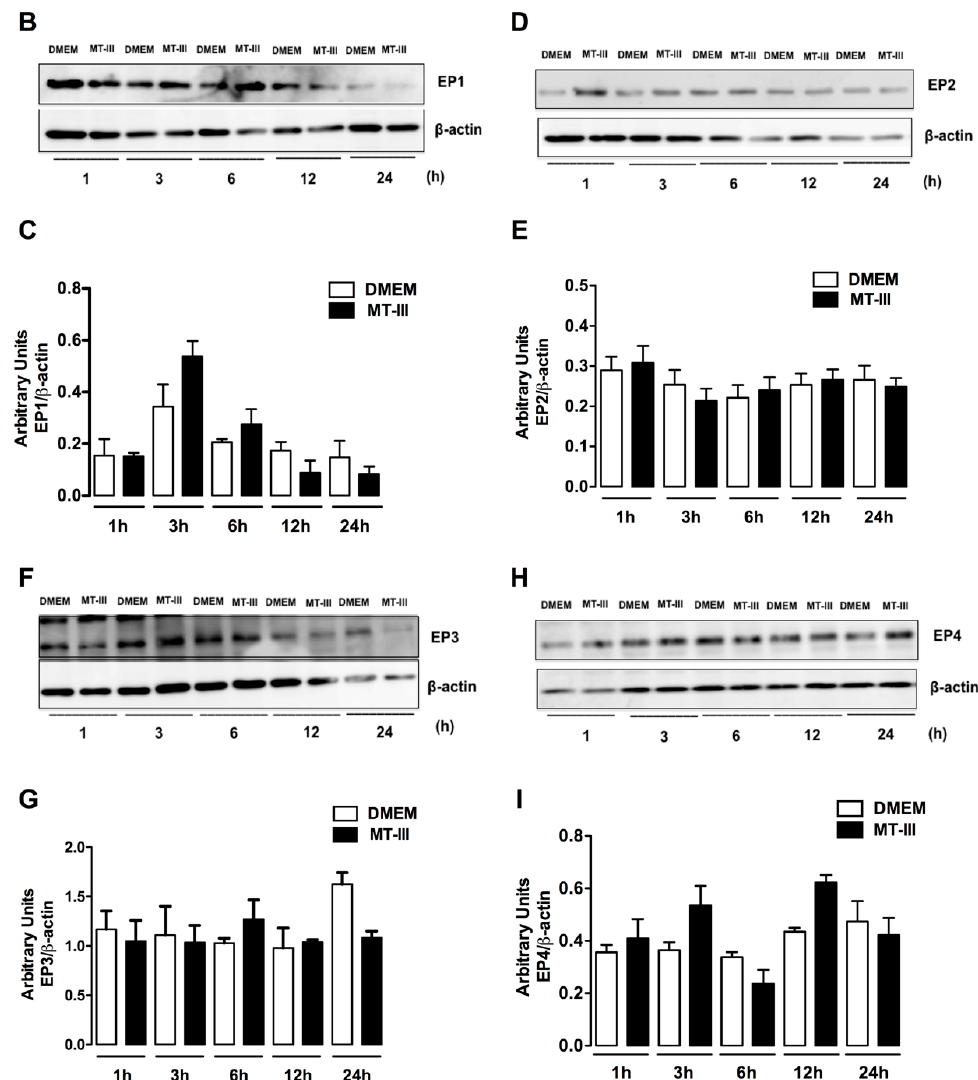
Figure 5. EP4 receptor participates in MT-III-induced PGE 2 biosynthesis in 3T3-L1 preadipocytes. ( A ) Preadipocytes were incubated with SC-19220 (10 μ M), AH6809 (10 μ M), L-798106 (1 μ M) or AH23848 ( A ) Preadipocytes were incubated with SC-19220 (10 µ M), AH6809 (10 µ M), L-798106 (1 µ M) or AH23848 (10 μ M) for 1 h followed by incubation with MT-III (0.4 μ M) for 6 h. PGE 2 concentrations were (10 µ M) for 1 h followed by incubation with MT-III (0.4 µ M) for 6 h. PGE 2 concentrations were